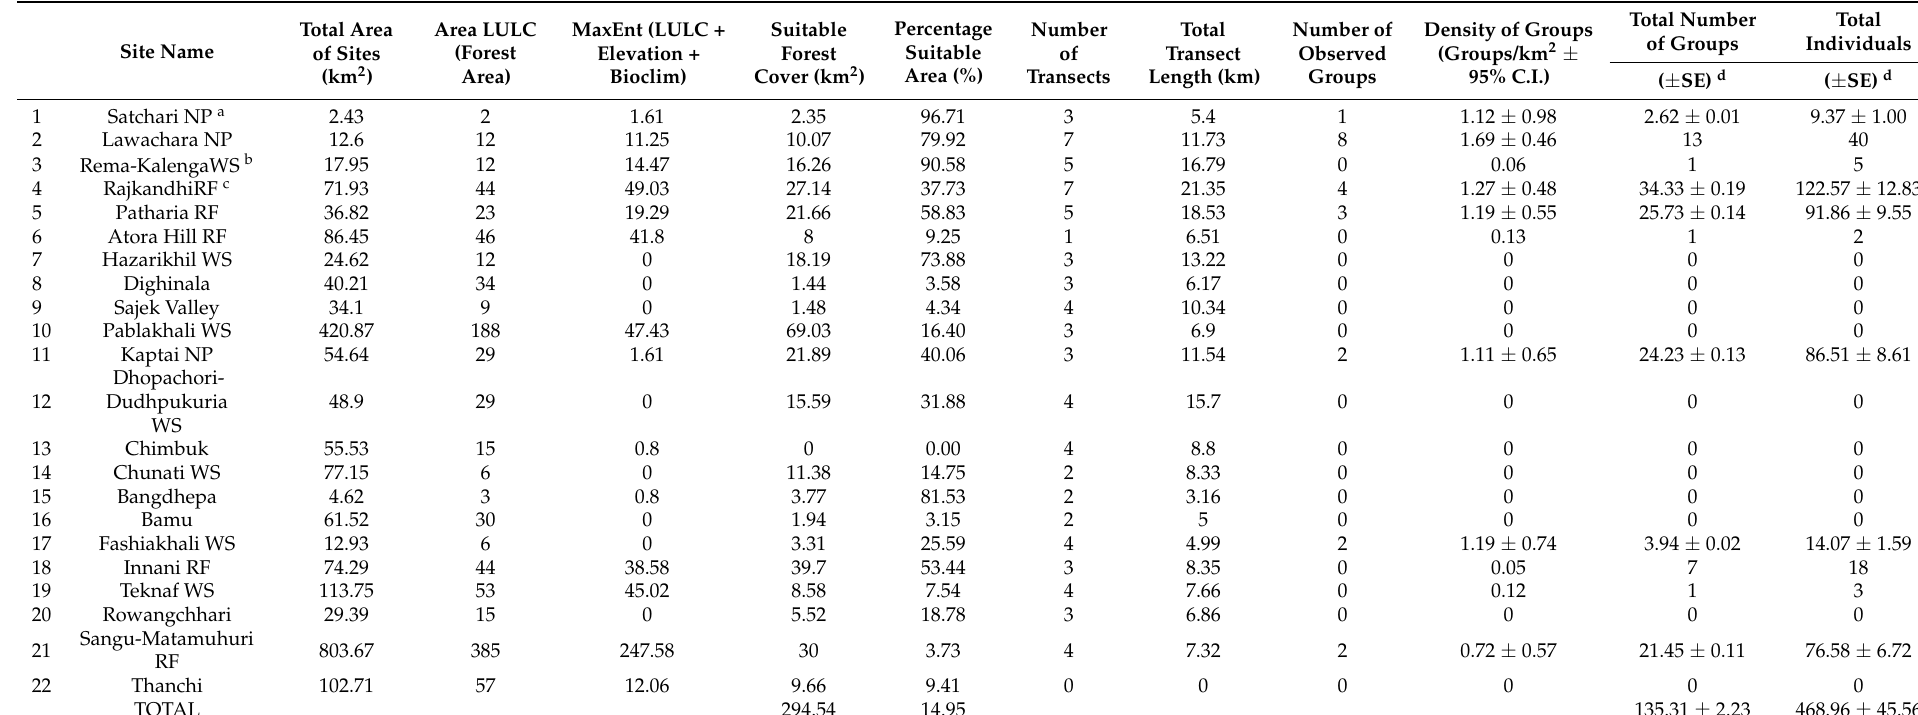
Table 2. Estimated group density, total number of groups and individuals in populations of western hoolock gibbons in